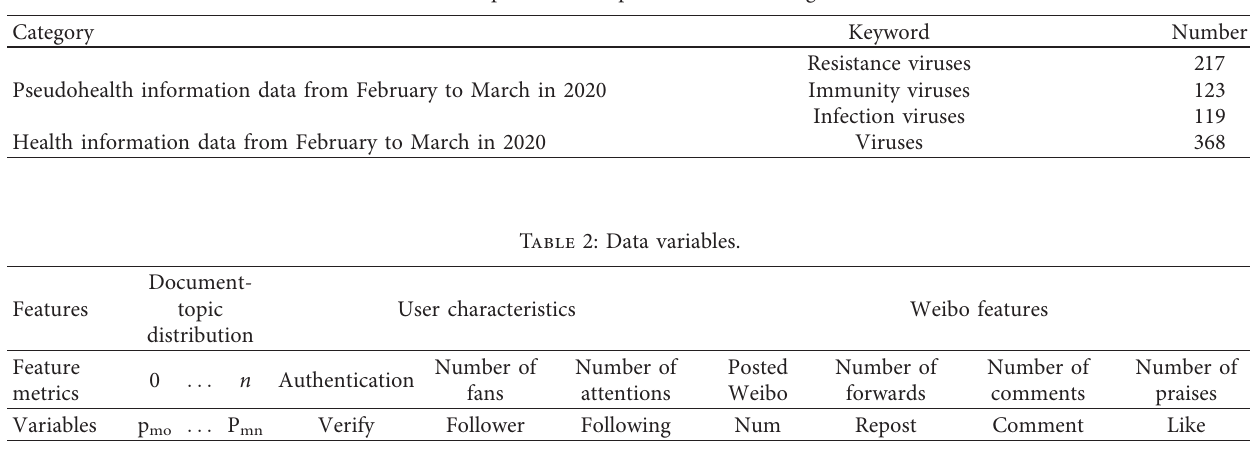
A LGORITHM 2: Semantic deviation detection algorithm. Table 1: Composition of experimental microblog datasets.